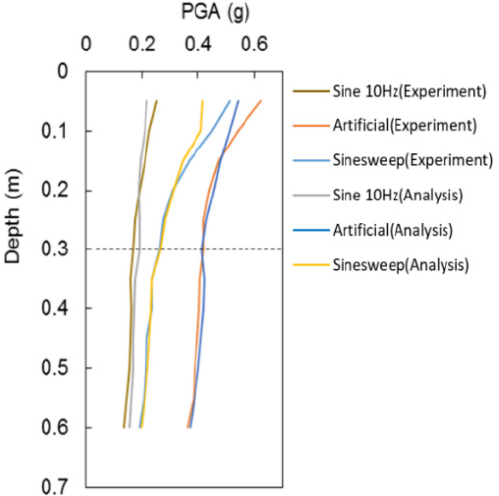
13 of 18 Figure 13. Normalized soil shear modulus and material damping ratio relationship. 4.2. Comparison of Numerical Analysis Results and Shaking Table Test Results The response data of the accelerometer buried deep in the center of the multilayered, flat ground model and the one-dimensional ground response analysis results were com- pared through the peak ground acceleration and spectral acceleration curves. Figure 14 compared the peak ground acceleration for each input wave. For the peak ground acceleration, it was confirmed that the experiment and numerical analysis results of each input seismic shaking were generally consistent, but acceleration obtained by nu- merical analysis was less than the experimental value at the top. This is considered to be because the acceleration at the top layer of the model increases due to resonance in the process of shear wave velocity measurement, which resulted in increase of shear wave velocity. During the hammer test, the soil layer in the soil box will settle to a certain extent due to gravity and shock, resulting in a decrease in height and an increase in frequency, which just produces an enhancement effect with part of the artificial seismic waves and